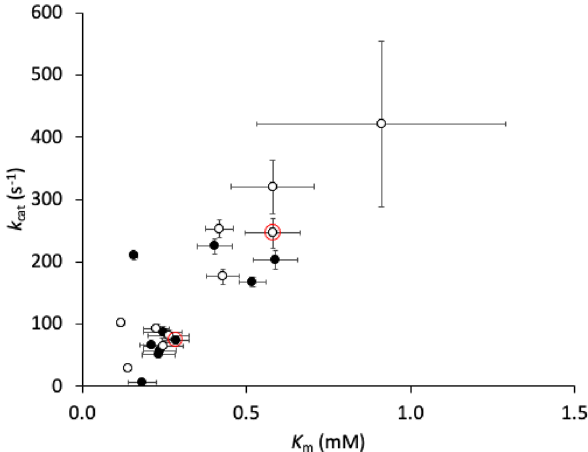
Figure 6. Relationship between catalytic turnover rate ( k cat ) and Michaelis–Menten dissociation constant ( K m ) for characterized variants expressed at (White circle) 30 °C and (Black circle) 37 °C. Red circles highlight the parent V15Q/R82P/C112S.